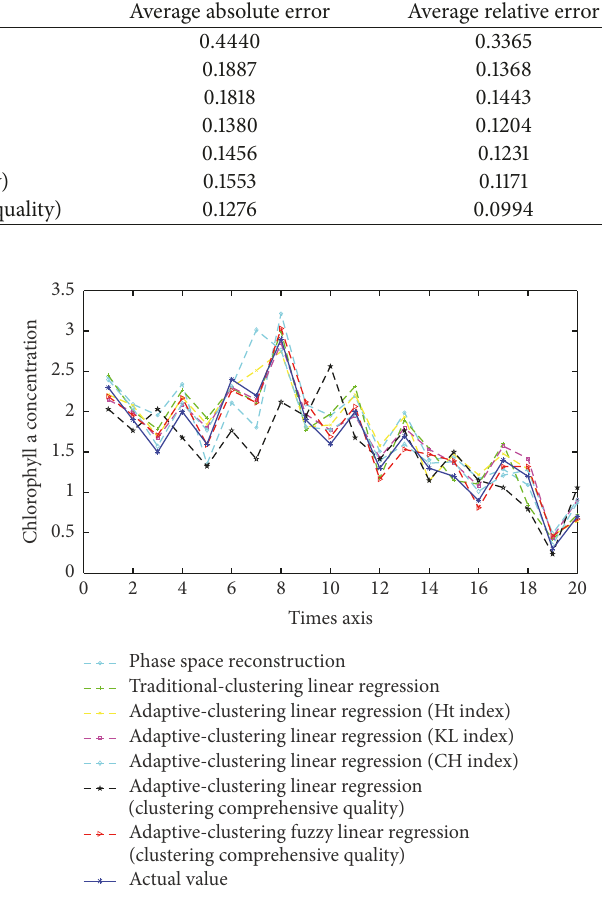
Figure 4: Comparison of results of prediction